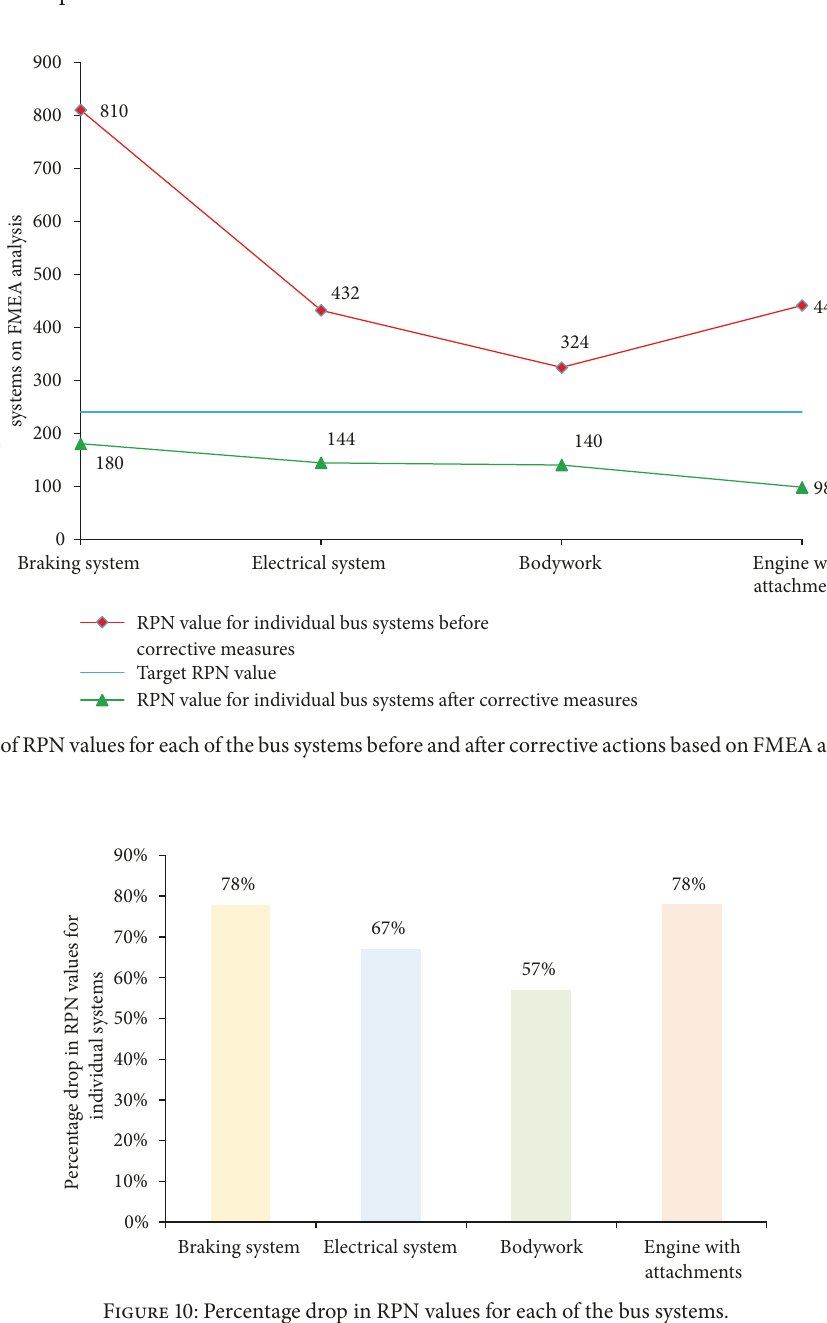
Figure 10: Percentage drop in RPN values for each of the bus